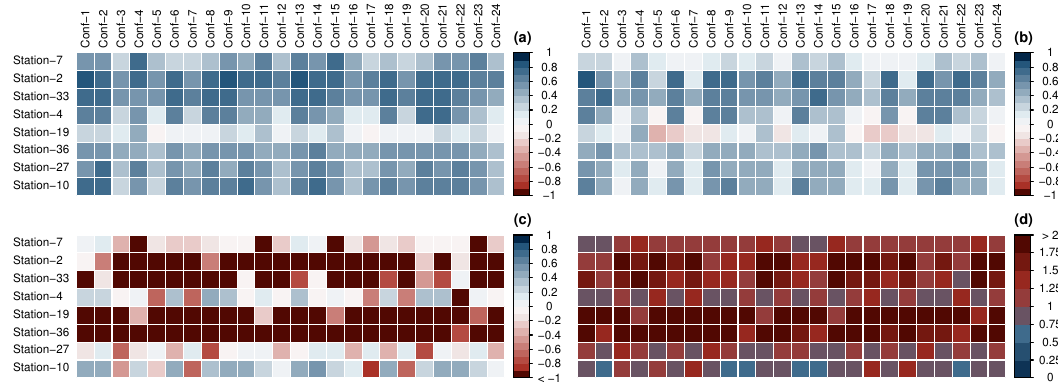
Figure 6. Matrix of statistics for relative humidity: ( a ) correlation, ( b ) KGE, ( c ) NSE, ( d )